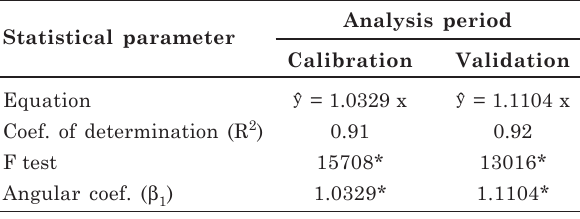
Table 4. Results of linear regression of the SWAT simulation of daily runoff in the Galo creek watershed, during calibration and validation